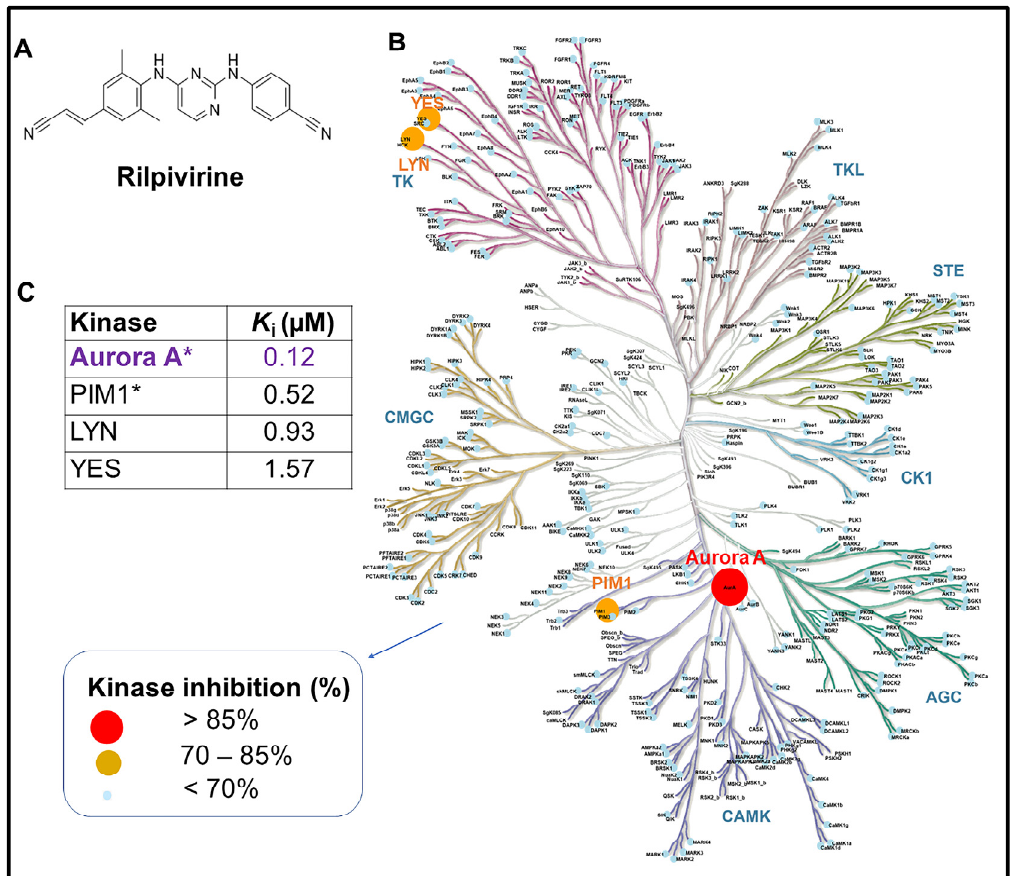
Figure 1. Structure and kinome-wide selectivity profile of rilpivirine . ( A ) Chemical structure of rilpivirine ((E)-4-((4-((4-(2-cyanoethenyl)-2,6-dimethylphenyl)amino)pyrimidin-2-yl)amino)benzonitrile). ( B ) Kinome map showing kinome-wide selectivity of rilpivirine at 1 µM concentration. The percentages of kinase inhibition mediated by rilpivirine are represented by coloured circles depicted in the legend. The kinase residual activities (%) remaining after treatment with rilpivirine of 429 tested kinases are included in Supplementary Table S1. ( C ) The apparent inhibition constant ( K i ) value of each kinase with >70% inhibitory activity is presented in the table. K i value was calculated from the corresponding IC 50 value and the appropriate K m (ATP) value for each kinase. * Data were previously reported (in Ref [11]). The kinome map is reproduced by the courtesy of Cell Signalling Technology, Inc. Note: Atypical kinases tested were not depicted in the kinome map.